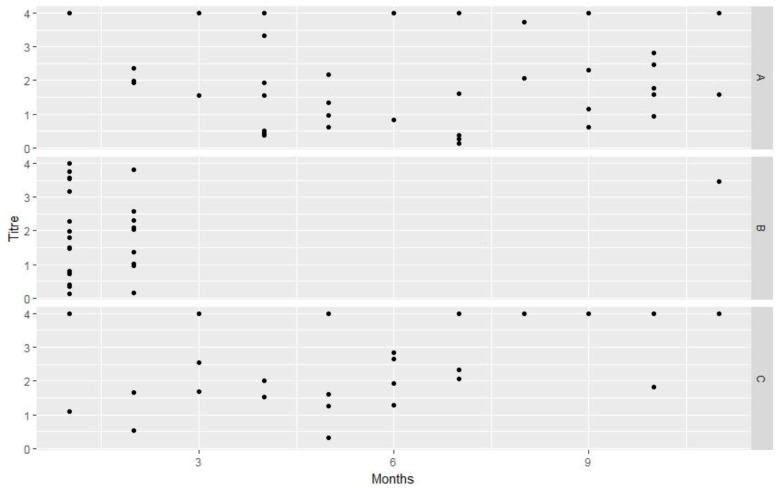
Quantity of anti-rabies antibodies in 110 dog serum samples determined by comparing the optical density of the sample to a standard curve (>4 EU/ml = high seroconversion level; 0.5–4 EU/ml = sufficient seroconversion level; 0.125–0.5 EU/ml = insufficient seroconversion level; <0.125EU/ml = undetectable seroconversion).